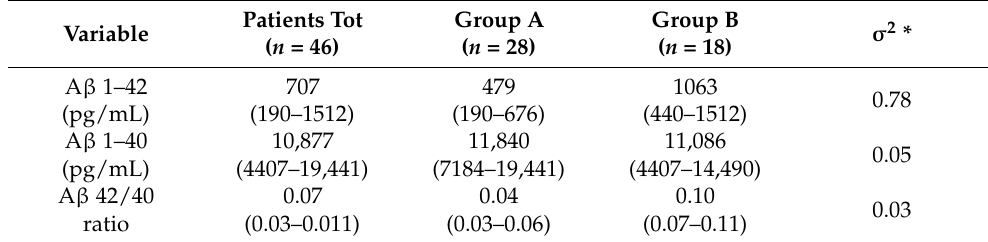
Table 1. Average values recorded for each variable. The minimum and maximum values are shown in parentheses; σ 2 is the variance of the values according to “one-way ANOVA”.